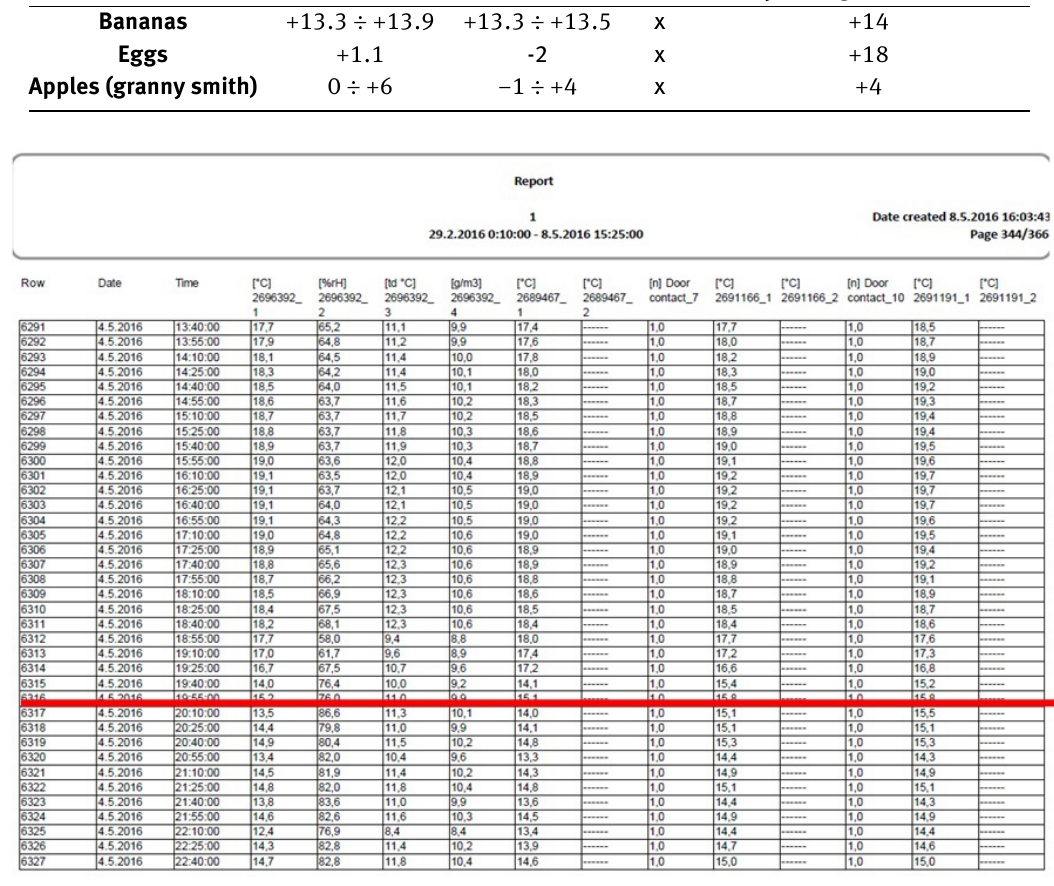
Figure 2: Transport temperatures of bananas. Transport between Madunice to